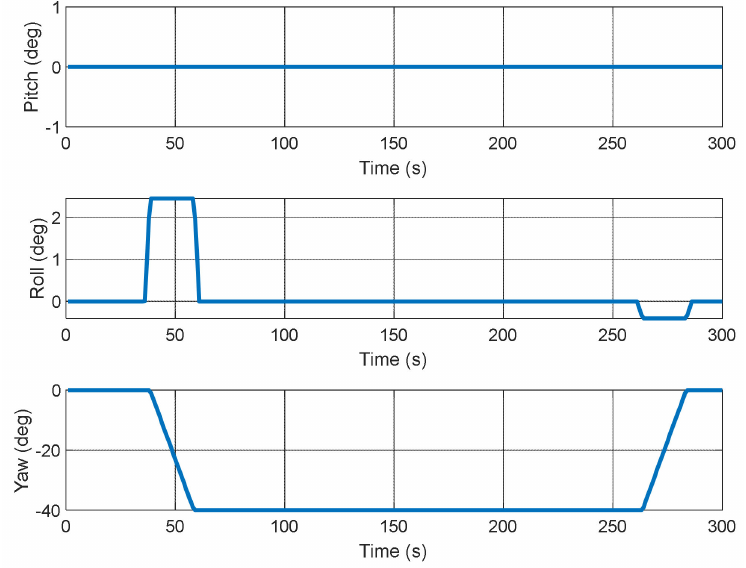
Figure 2. Reference angles.